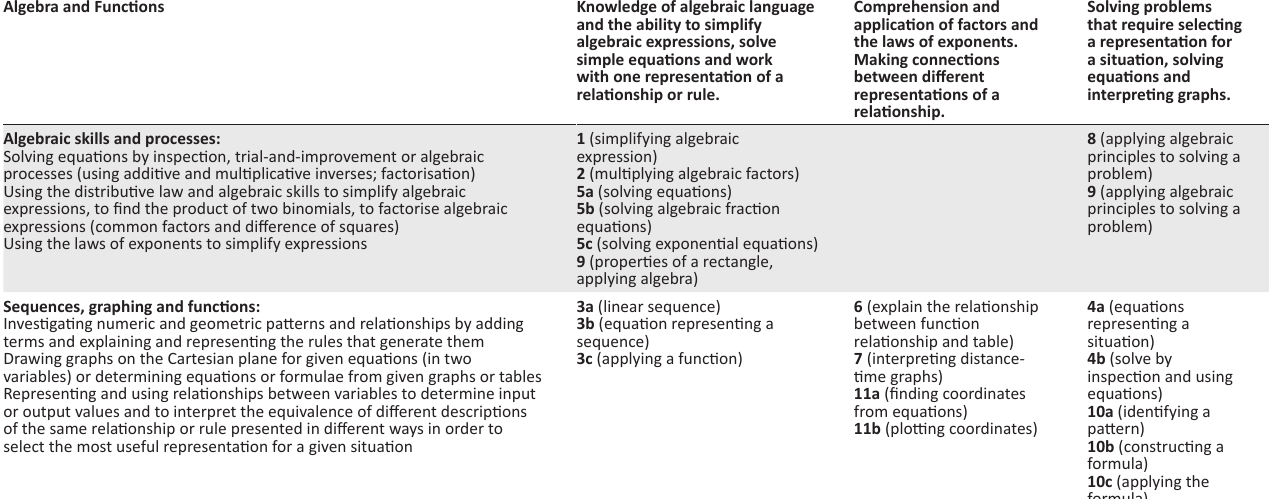
TABLE 1−A2: Adapted cognitive domain categories (Grade 9). Algebra and